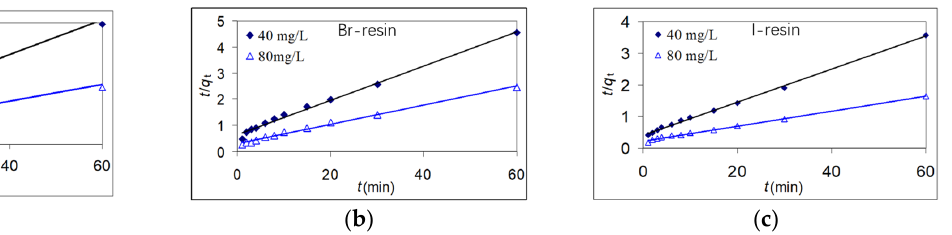
Figure 4. Pseudo-second order plots of Cd 2+ adsorption on X − -loaded resins. ( a ) Cl-resin, ( b ) Br-resin, ( c ) I-resin.